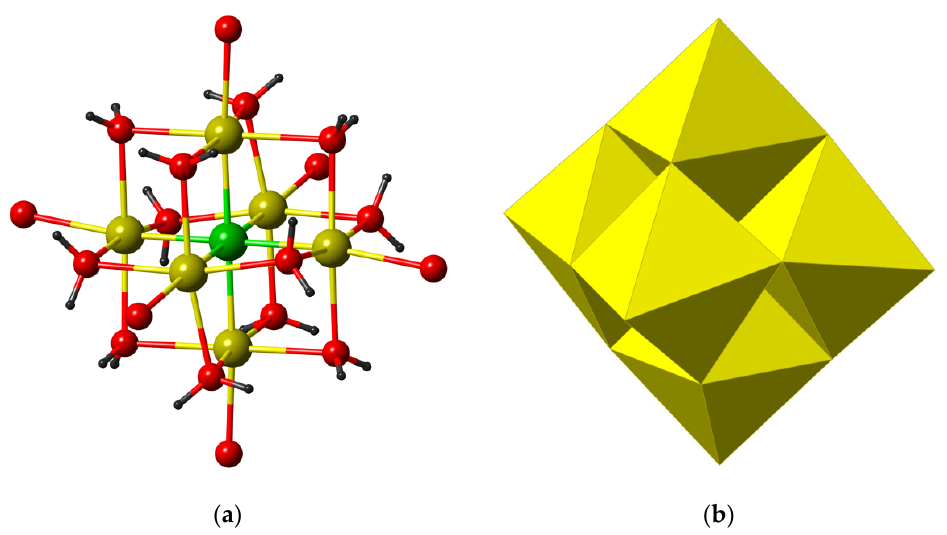
Figure 4. The super-octahedral [Na 6 (H 2 O) 18 F] 5+ polycationic cluster in the crystal structure of natrophosphate: ( a ) ball-and-stick representation; ( b ) representation in terms of (NaF 6 ) octahedra (shown in yellow). Legend: Na, F, O and H atoms are shown as yellow, green, red and black spheres, respectively.